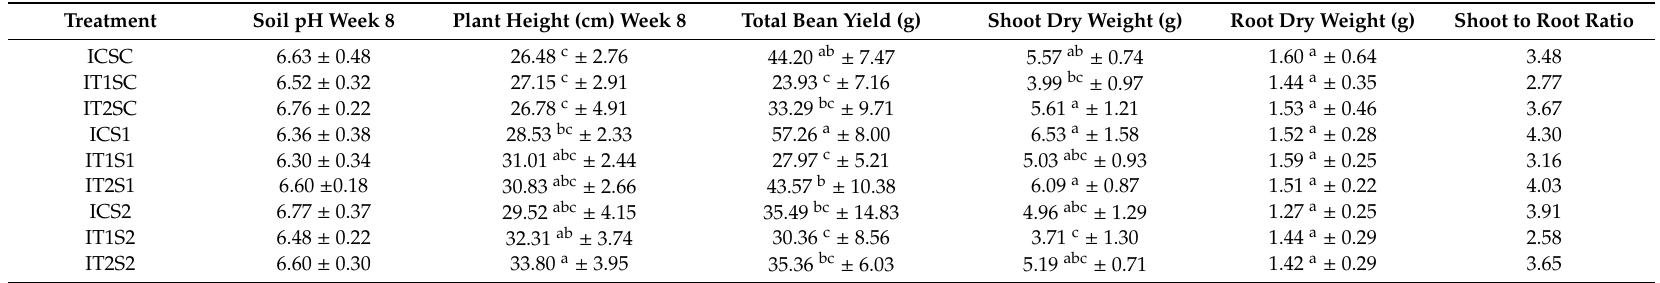
Table 1. E ff ect of salinity level and inoculation types on soil pH, plant height, yield, root and shoot weights of snap